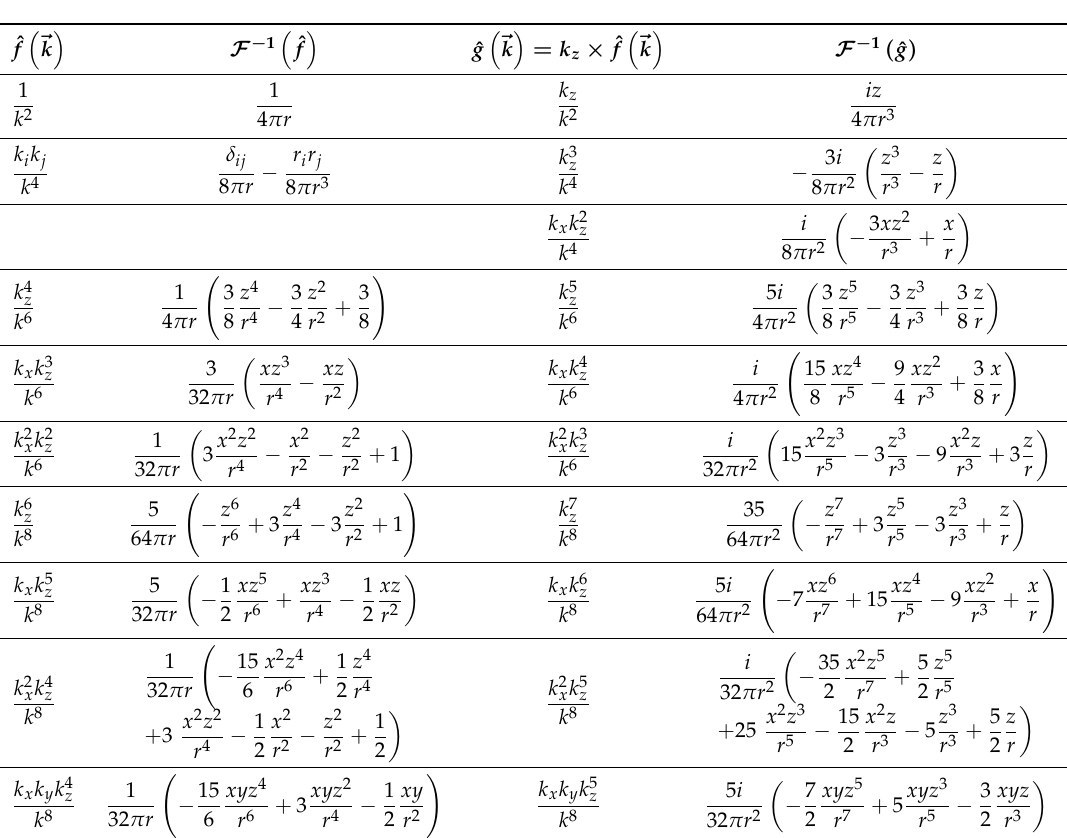
Table 1. A list of inverse Fourier transforms used in this article, obtained by the procedure, described in [51]. Note that the expressions form self-consistent pairs bound by the relation (cid:16) (cid:17) (cid:16) (cid:17) ˆ f ( (cid:126) k ) ˆ f ( (cid:126) k ) × k ∂ F − 1 = i F − 1 i ∂ r i